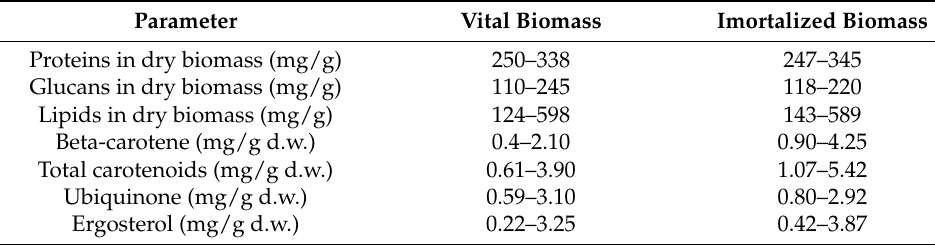
Table 1. Typical composition of red yeast biomass ( Rhodotorula kratochvilovae ) [11–13]. Parameter